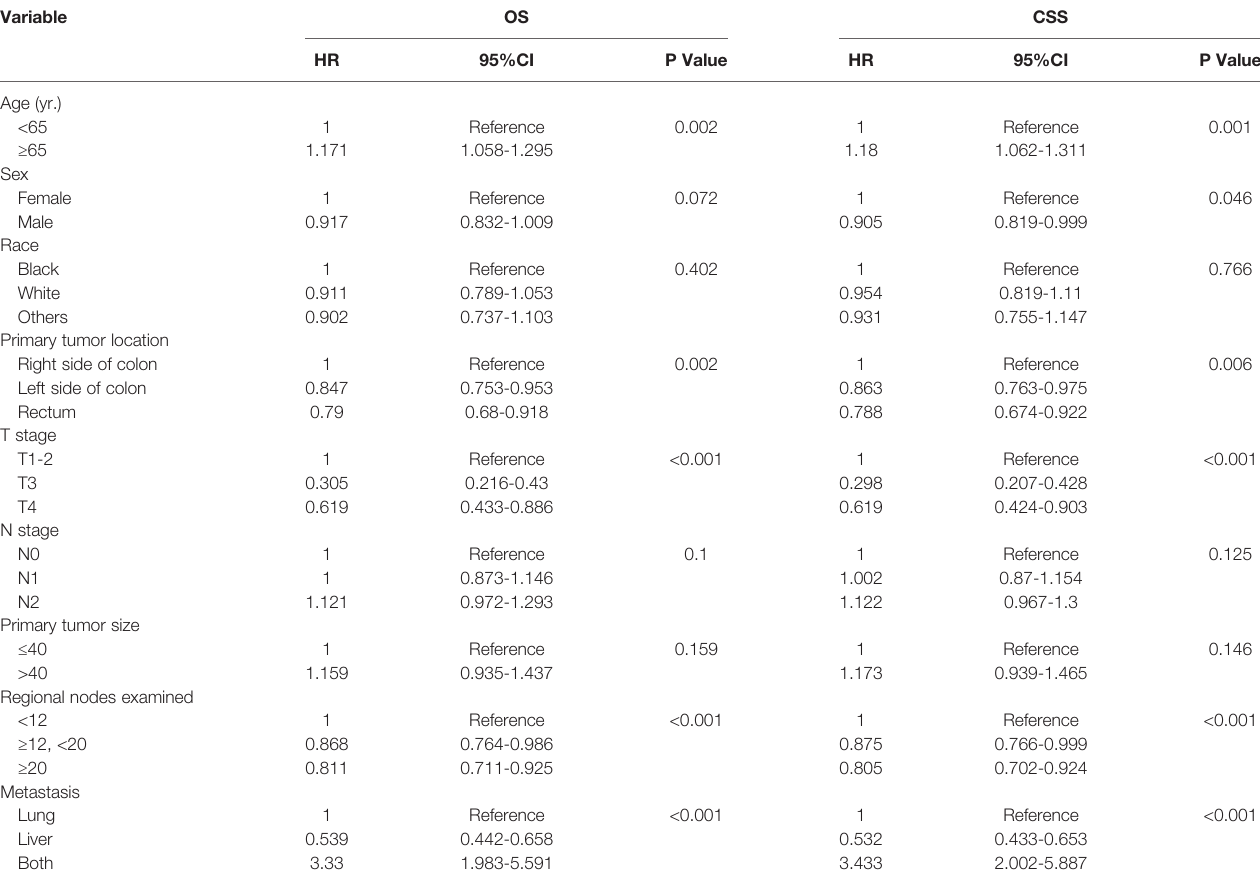
TABLE 2 | Univariate analysis of the prognostic factors of OS and CSS after resection of LM and/or PM in CRC.